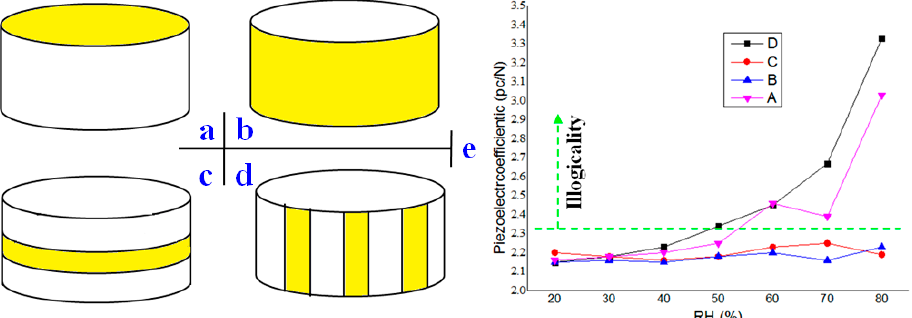
Figure 10. Different FAS patterns and results. ( a ) Fluoridation at up/down surface; ( b ) Fluoridation at side surface; ( c ) Ring fluoridation at side surface; ( d )Axial fluoridation along the side surface; ( e ) Piezoelectric coefficients of different FAS patterns in different RH.